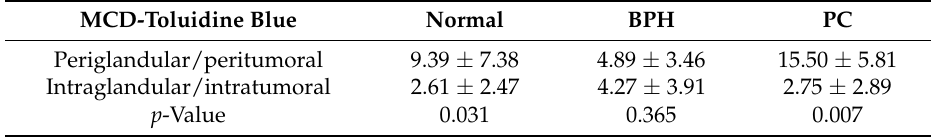
Table 1. Mast cell density (MCD) in periglandular/peritumoral areas versus intraglandular/intratumoral areas based on Toluidine Blue staining. p -Value is significant in normal and prostate carcinoma (PC) groups, but not in benign prostate hyperplasia (BPH) group.